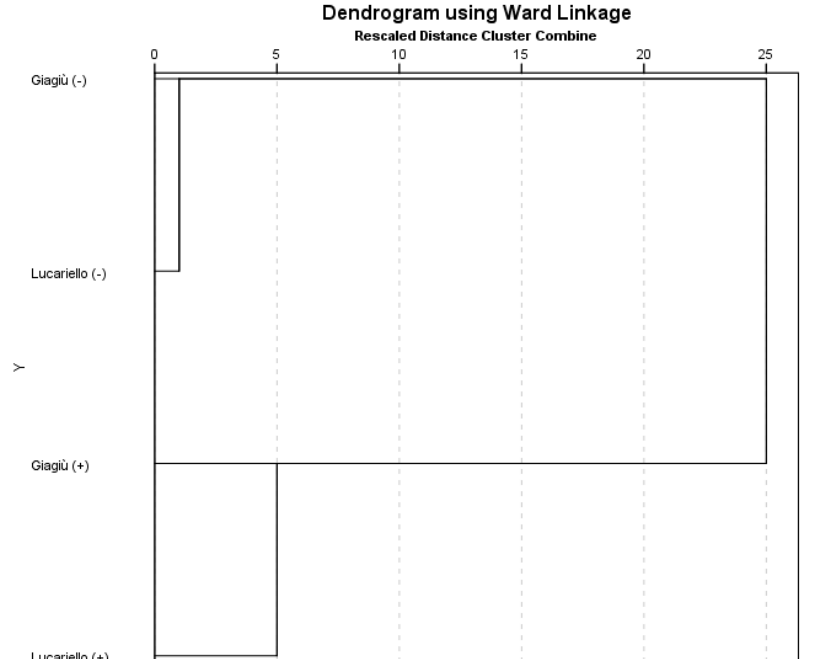
Figure 6. Hierarchical cluster analysis based on total yield, number of fruits, fruit mean weight, total soluble solids (TSS) content, dry matter, lipophilic and hydrophilic (LAA and HAA), starch, lycopene, sucrose, macro (phosphorus, potassium, calcium and magnesium) and micro (sodium, iron, copper, manganese and zinc) mineral content and total amino acids content.